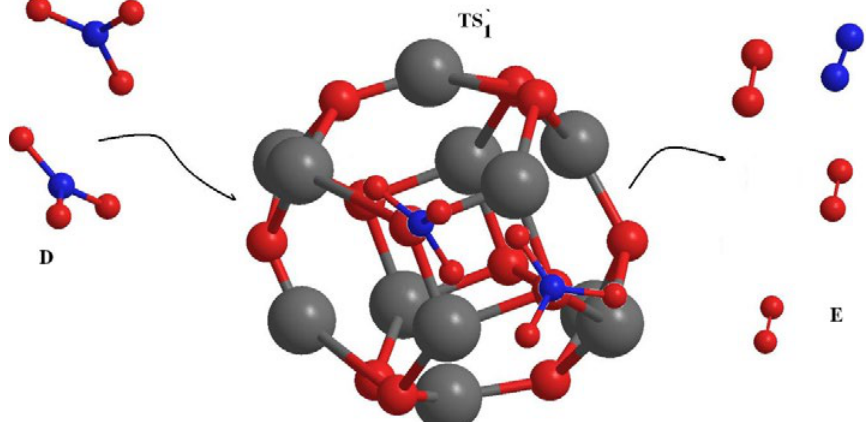
O nano-cage. 12 12 ), heat of reaction formation total